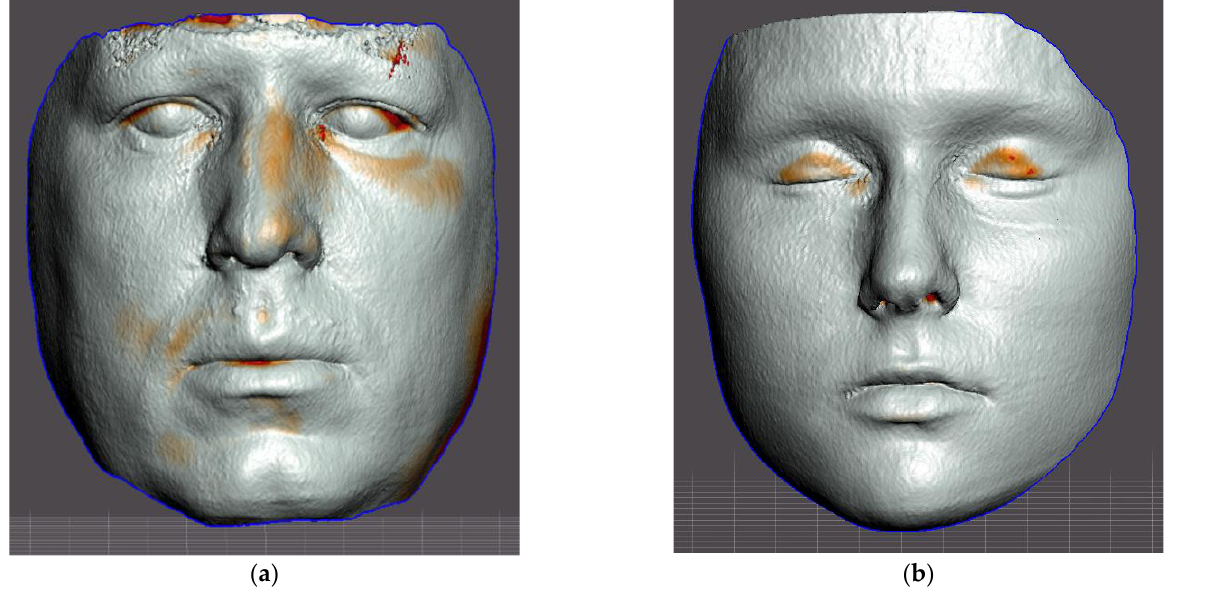
Figure 6. Examples of aligned segmented CBCT face surfaces and face TrueDepth–Bellus3D scans of authors of this paper. On the resulting differential maps (heatmaps), red indicates differences between both scans: ( a ) Left surface shows frequent disruptive artifacts on the upper border of CBCT scan; ( b ) The right scan shows frequent differences resulting from eyes closed during the CBCT scanning.